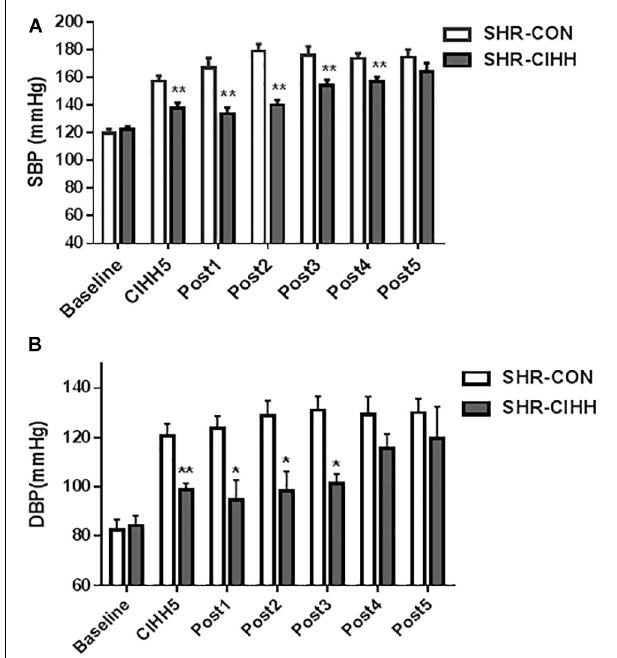
FIGURE 2 | The duration of the depressor effect by chronic intermittent hypobaric hypoxia (CIHH) on SBP (A) and DBP (B) in spontaneously hypertensive rats (SHRs). (A) SBP: systolic blood pressure; (B) DBP: diastolic blood pressure. Data are expressed as mean ± SEM; SHR-CON: control SHR ( n = 6); SHR-CIHH: SHR with CIHH ( n = 6); CIHH5: 5 weeks of CIHH; Post 1–Post 5: 1–5 weeks after CIHH; * P < 0.05, ** P < 0.01 vs. SHR-CON ( t